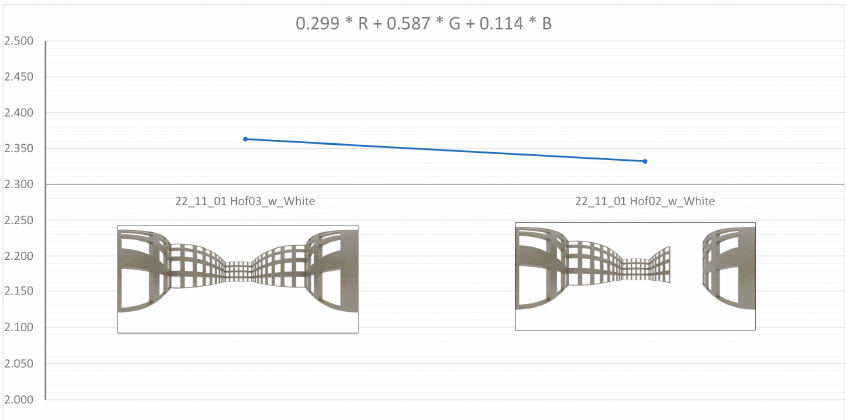
Figure 9. Measurement method “Grayscale DBX M × N ( m × m ) (shifting boxes)” with the grayscale conversion adapted to the perception of brightness (see Formula (13)) applied to a closed ( left ; image “22_11_01 Hof03_w_White”; D B = 2.363 with a correlation of 0.998963) and an open square ( right ; image “22_11_01 Hof02_w_White”; D B = 2.332 with a correlation of 0.999166). Changing the window proportions of just a few façades within the same courtyard (with otherwise unchanged façades) led only to small differences in the results. As can be seen in Figure 10, the box-counting dimension increased only marginally as more rows of windows were introduced, with the number of windows increasing while their height